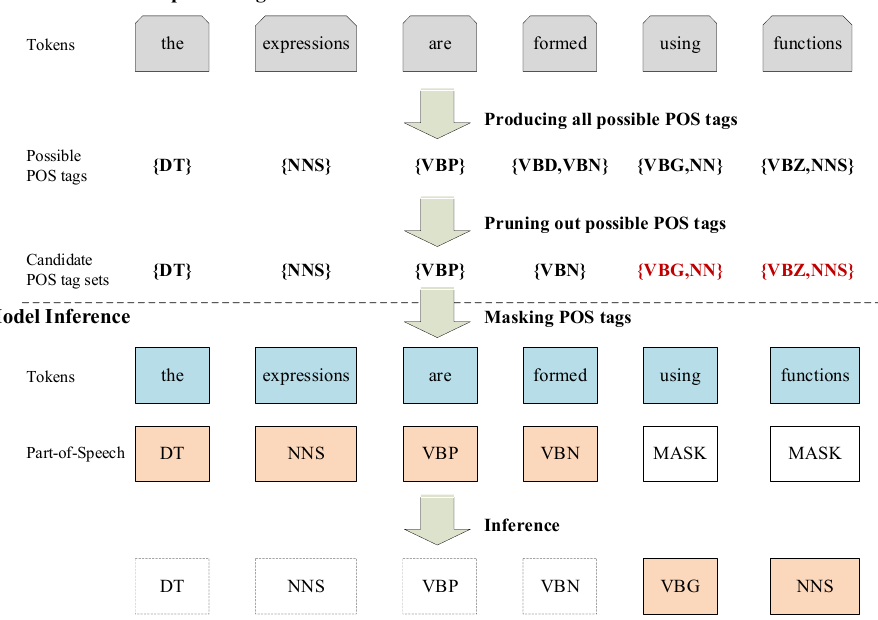
Figure 1. POS tagging for the sentence: “The expressions are formed using functions” . In the step of pruning out possible POS tags, the POS tag VBD of the token formed is eliminated after one of our rules is used to tag the verb following the token are as VBN or VBG. For the token using and functions , their POS tags cannot be determined and are therefore masked. In the inference phase, the masked POS tags are predicted by a deep learning model.